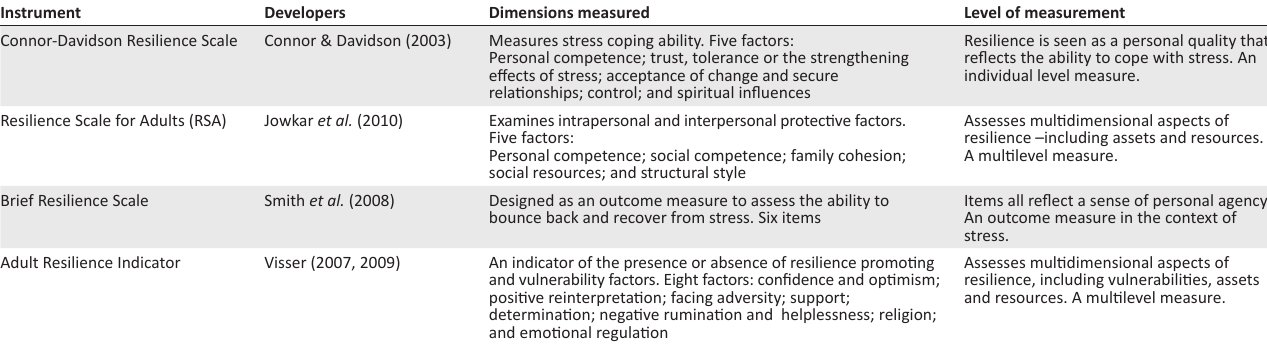
TABLE 1: Description of resilience